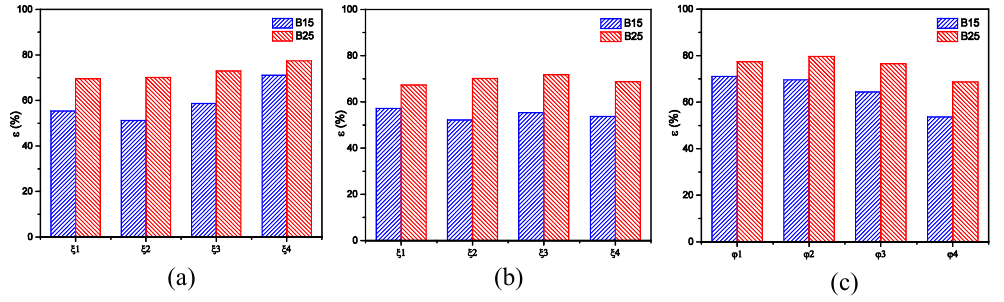
Figure 5. Adhering fuel mass ratio (ε) of B15 and B25 with different wall conditions: ( a ) dry walls with different roughness; ( b ) FWW with different roughness; ( c ) SWW with different φ ’ .